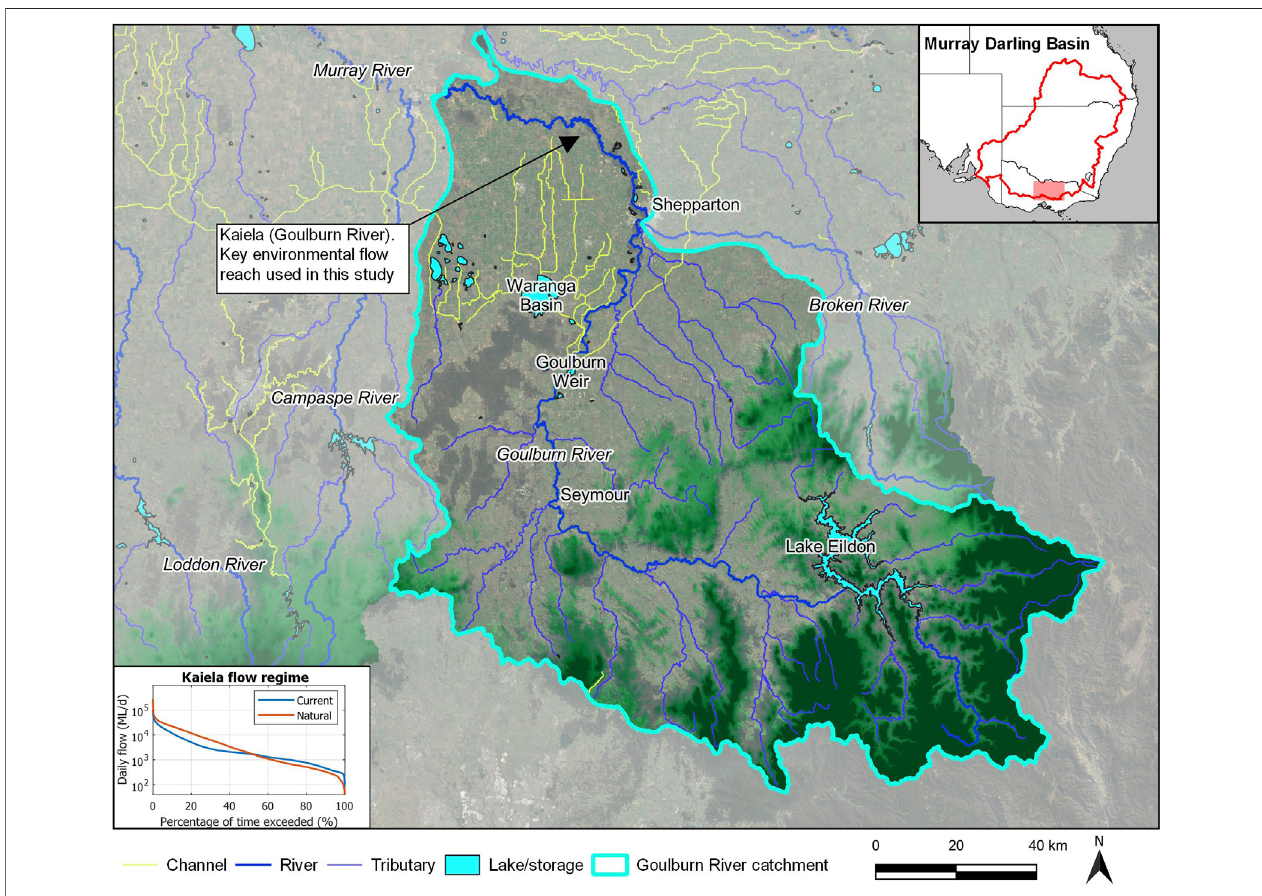
FIGURE 1 | Case study catchment of the Goulburn River basin. The fl ow duration inset describes Kaiela fl ow conditions in current and “ natural ” (modelled without regulation structures and diversions) conditions. Compared to more natural conditions, rarer fl ows are lower in magnitude, and more common fl ows are higher in magnitude for the current regulated